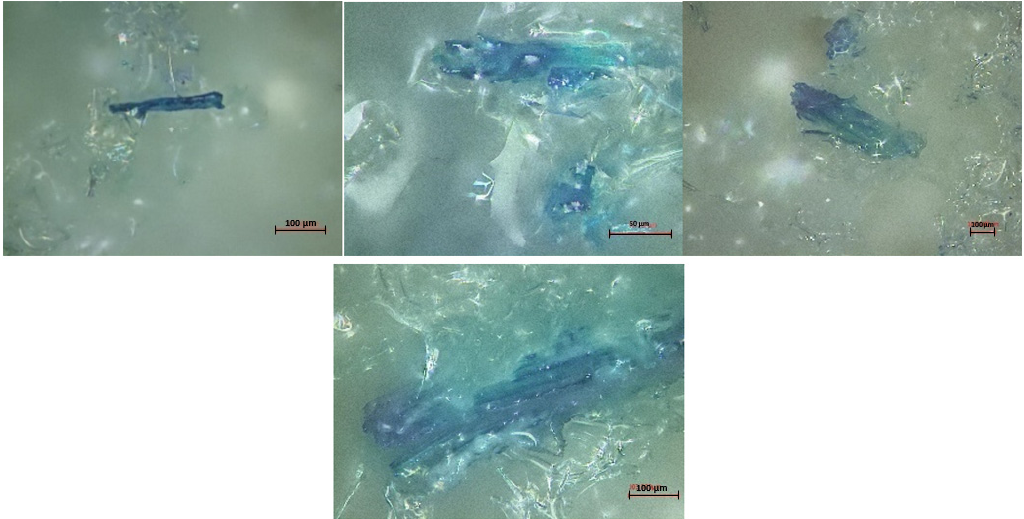
Figure 12. Microscopic observation of single fibers interaction with Polyisocyanurate foam.